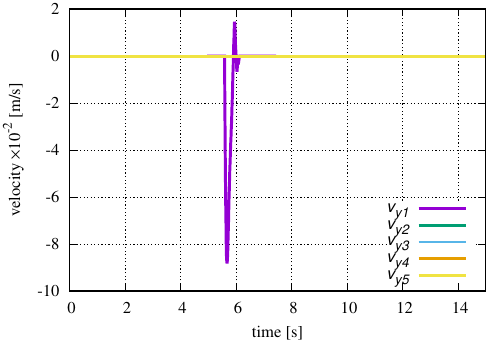
Figure 13. Case 1: Time variation of the velocities in the axial direction.